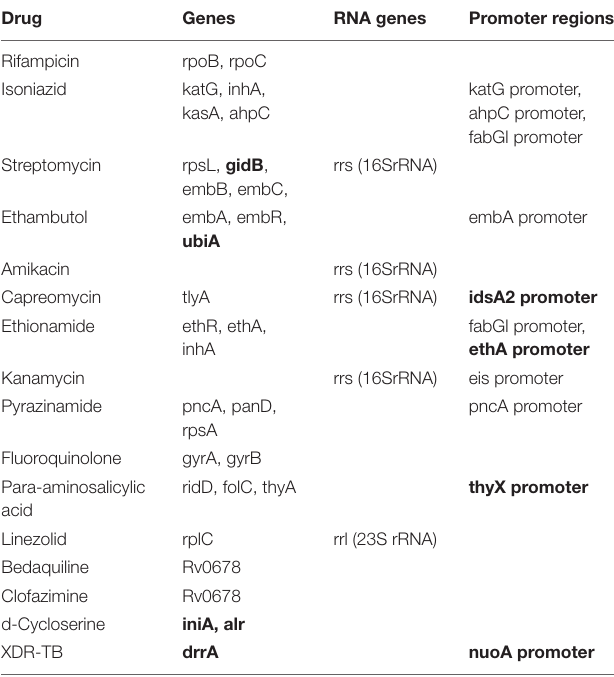
TABLE 1 | Genes and genomic regions of interest for drug resistance in M. tuberculosis . Drug Genes RNA genes Promoter